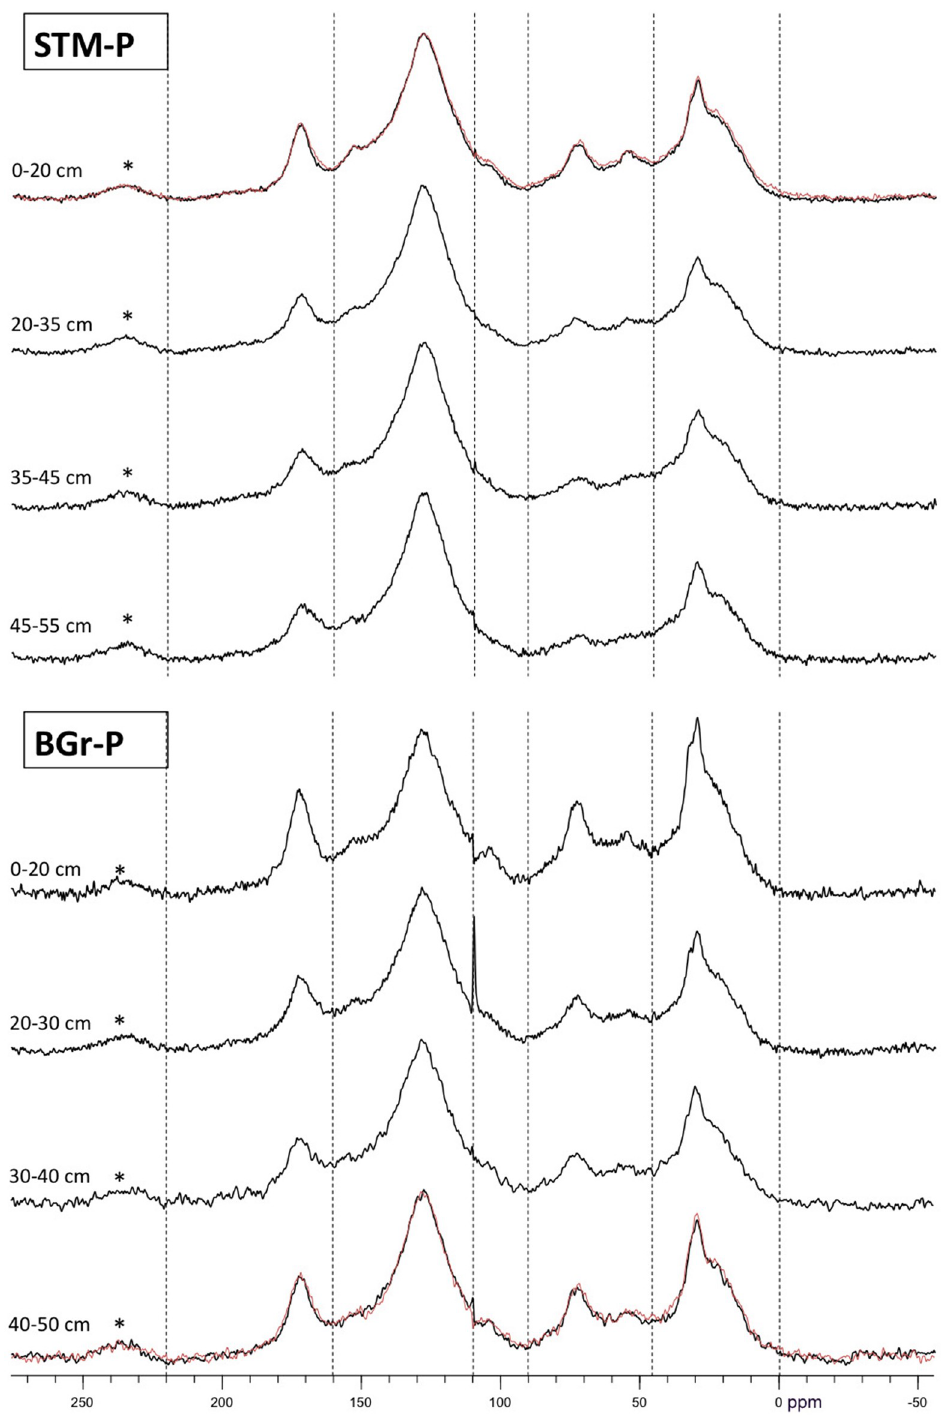
Fig 6. 13 C-CPMAS NMR spectra of HF treated soil samples from four depths at the urban STM-P and extra- urban BGr-P sampling sites. Dashed lines demarcate integration limits as given in Table 1. The overlaid red spectra are repetition measurements to demonstrate reproducibility within each set. Spectra were normalized graphically to the most prominent peak at 129 ppm ( � = spinning side bands).